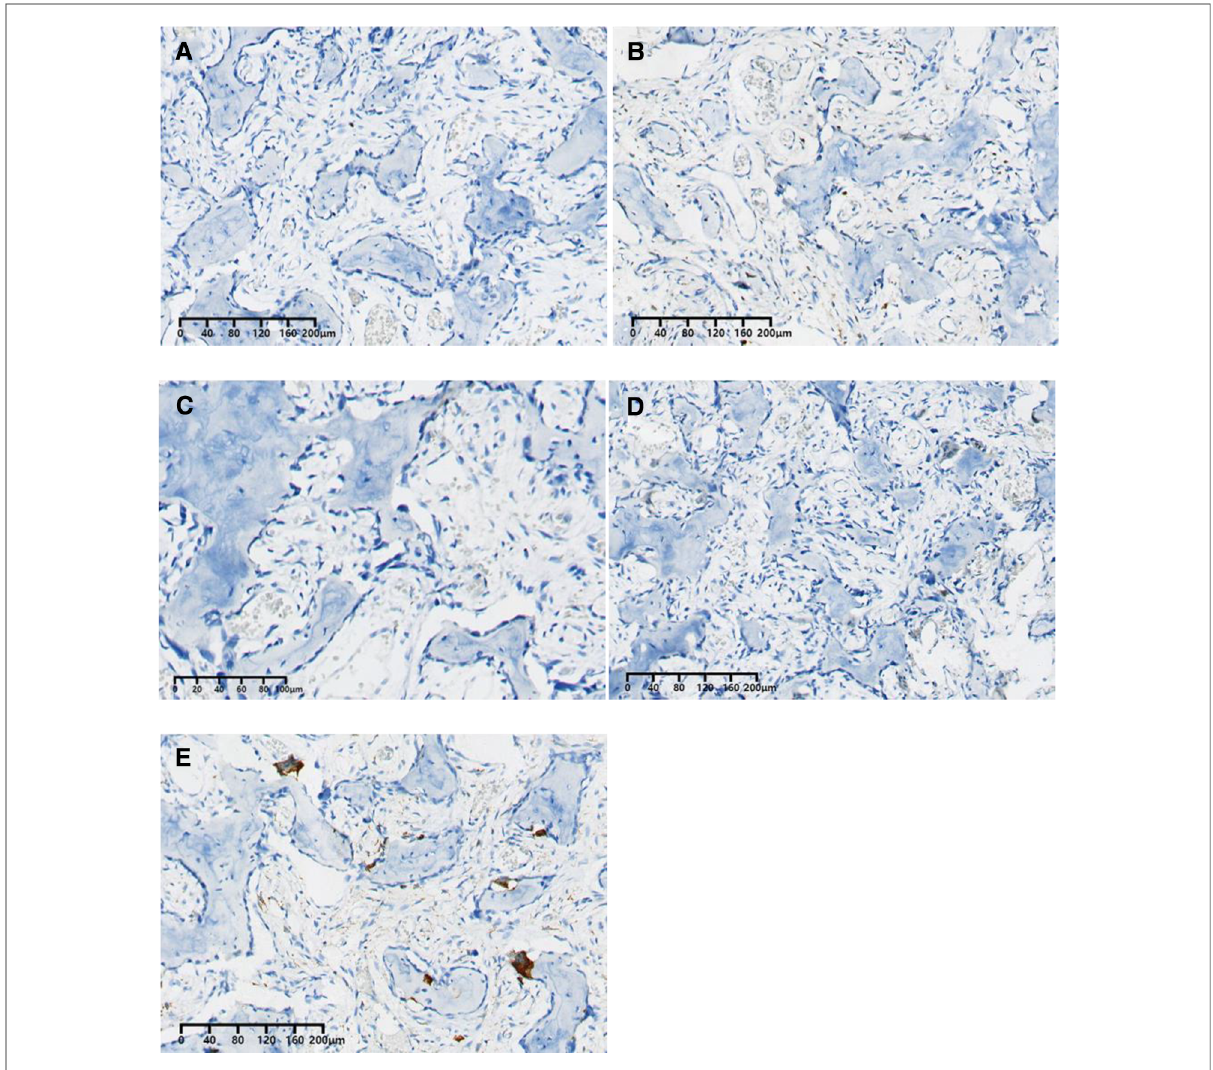
FIGURE 4 Immunohistopathological results: (A) Ki-67 (<5%); (B) PCNA (<5%); (C) SOX2 (+); (D) MDM2 (+); (E) CD68 scatteredly expression